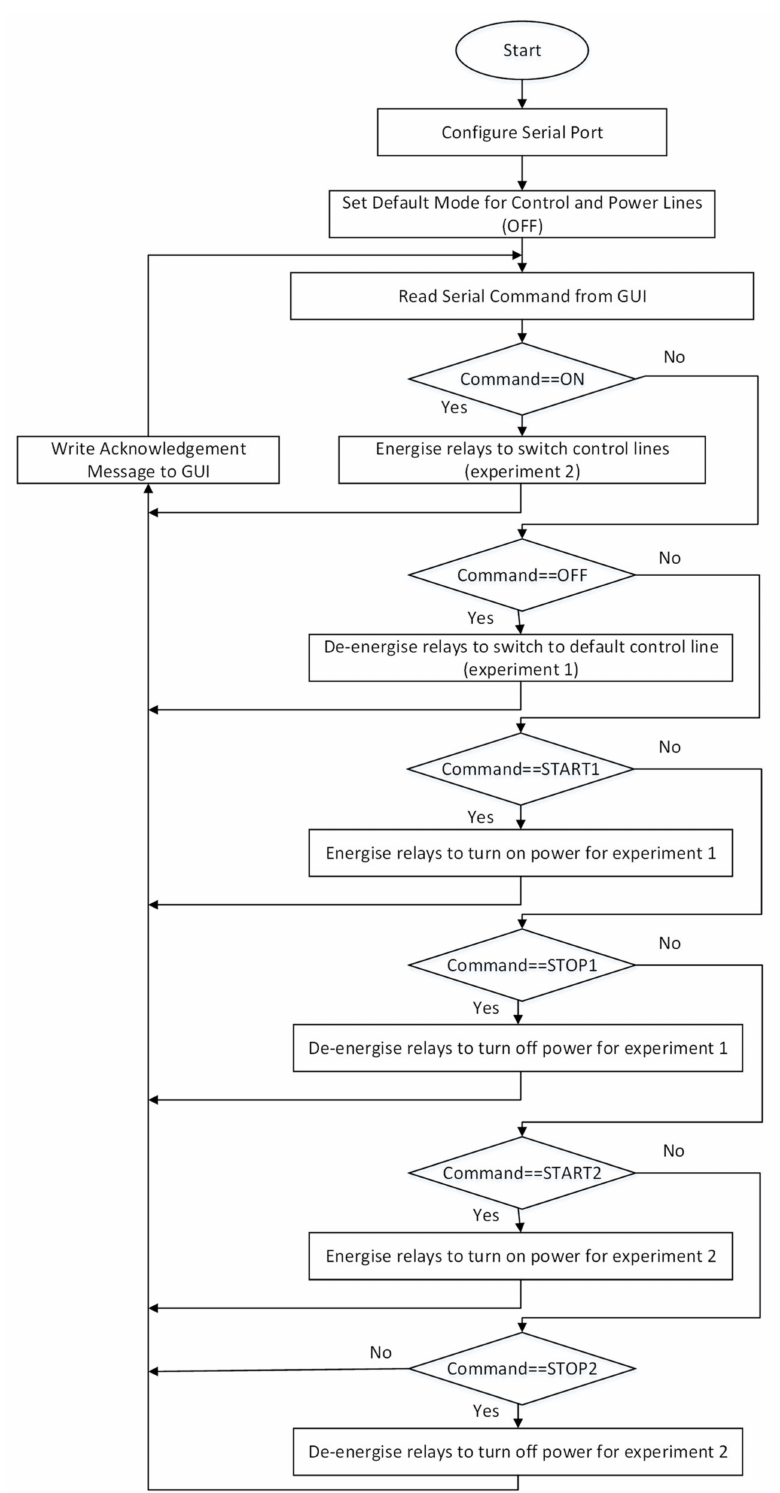
Figure 9. Flowchart of the micro-controller control